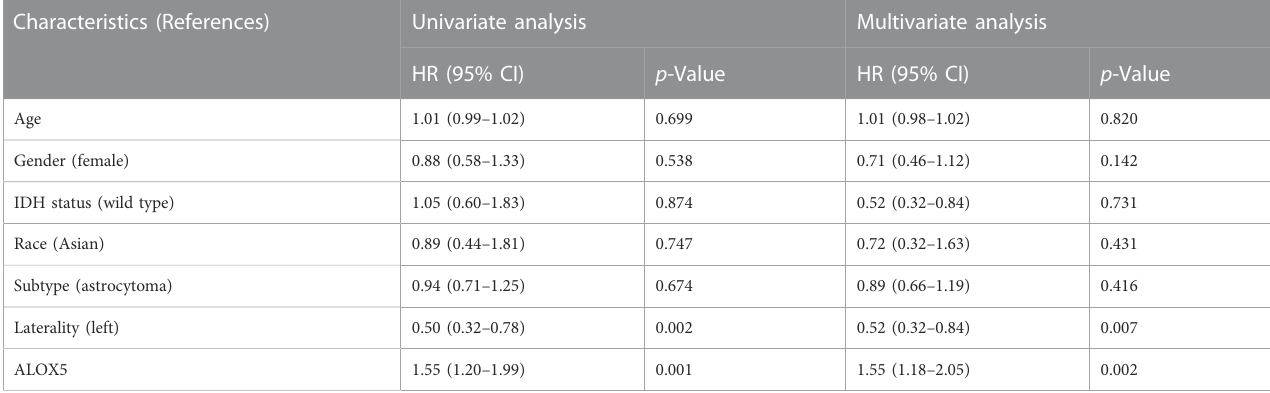
TABLE 4 Cox regression analysis of the association of ALOX5 and clinical variables with PFI in the TCGA-LGG dataset. Characteristics (References)